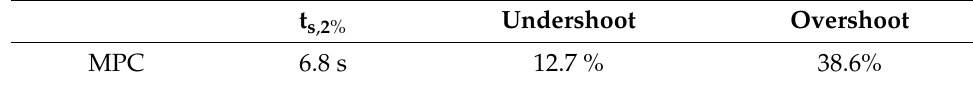
Figure 8. Euler angles ( top ), inertial velocities ( bottom left ) and altitude change ( bottom right ) in the experiment of steady state recovering from a random unsteady attitude. Table 7. Results of MPC recovering from a disturbed